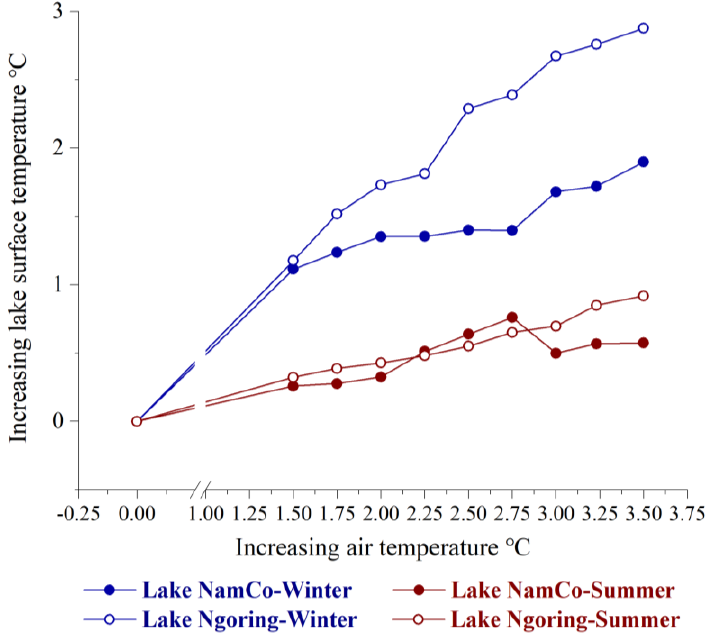
Figure 9. Plot of changes in LST in summer and winter for air temperature increases of between 1.5 °C and 3.5 °C at Lake Nam Co and Lake Ngoring (summer data are averaged from June, July, and August 2012 – 2016, and winter data are averaged from December, January, and February 2012 – 2016). ever, the LST rises much faster in winter than in summer, and the increase is greater at Table 1. Changes in lake ice thickness, the number of frozen days, and dates for the onset of freeze-up and melt when the air temperature increases by between 1.5 °C and 3.5 °C at Lake Nam Co and Lake Ngoring (averaged from January 2012 to December 2016).